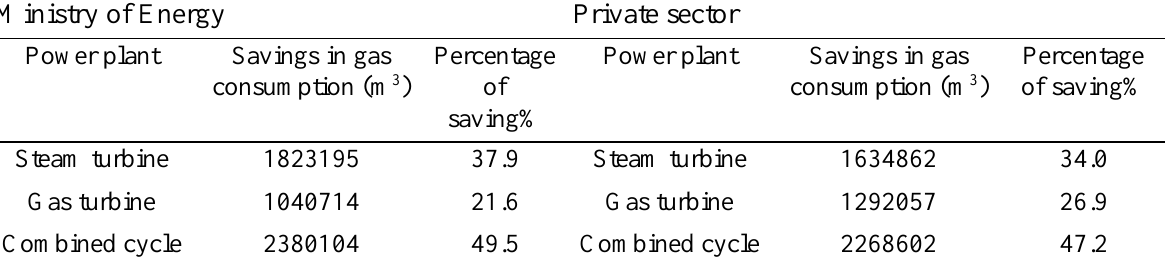
Table 3. Gas consumption savings.